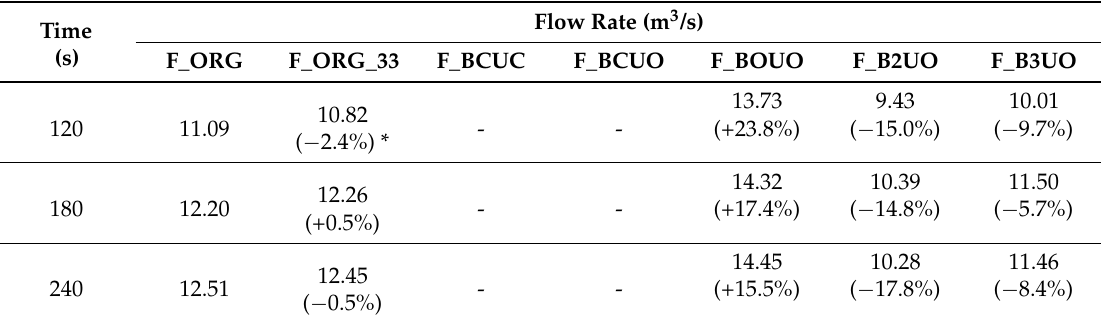
Table 7. Total flow rates of inlets below the podium for different cases.